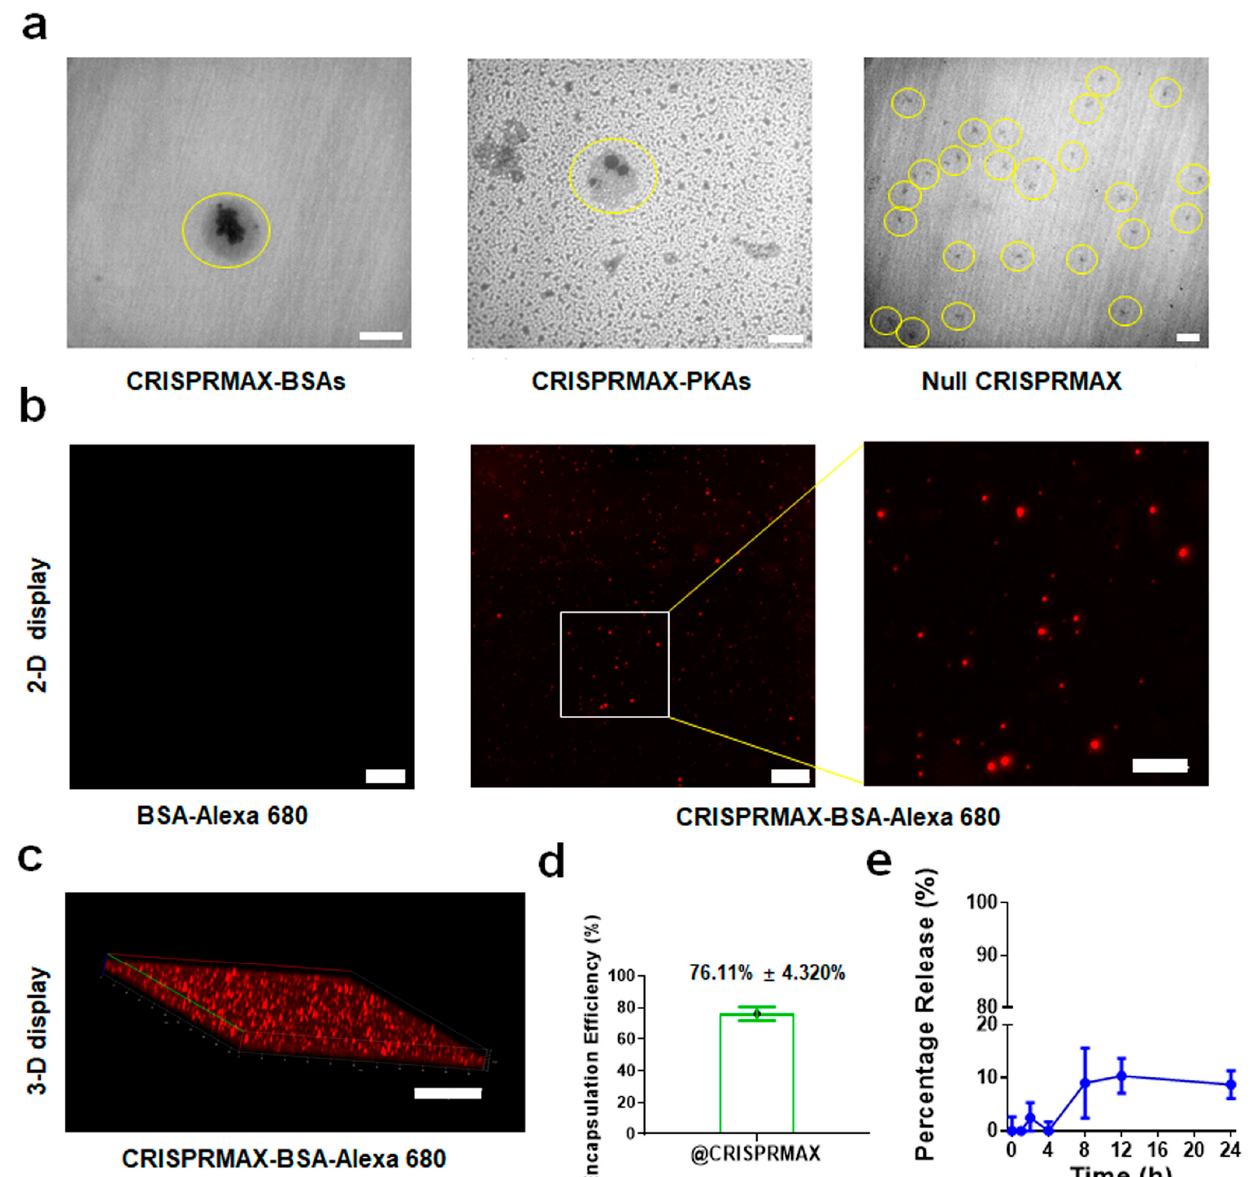
Figure 1. Characterization of PKAs- and BSAs-loaded CRISPRMAX complexes. ( a ) TEM images of CRISPRMAX-BSAs, CRISPRMAX-PKAs and null CRISPRMAX; the yellow circles indicate the location of the complexes (scale bars, 500 nm in BSAs and PKAs, and 1 µ m in null complexes). ( b ) CLSM images of BSA-Alexa 680 and CRISPRMAX-BSA-Alexa 680 in a 2-D display under the same parameters; the right panel is a partial enlargement of CRISPRMAX-BSA-Alexa 680 in a 2-D display (scale bars, 20 µ m in the left and middle panels; 10 µ m in the right panel). ( c ) A CLSM image of CRISPRMAX-BSA-Alexa 680 in a 3-D display (scale bar, 50 µ m). ( d ) The encapsulation efficiency of CRISPRMAX based on the calculation of loaded BSA-Alexa 680. ( e ) The release efficiency of CRISPRMAX based on the calculation of loaded BSA-Alexa 680 at the indicated time